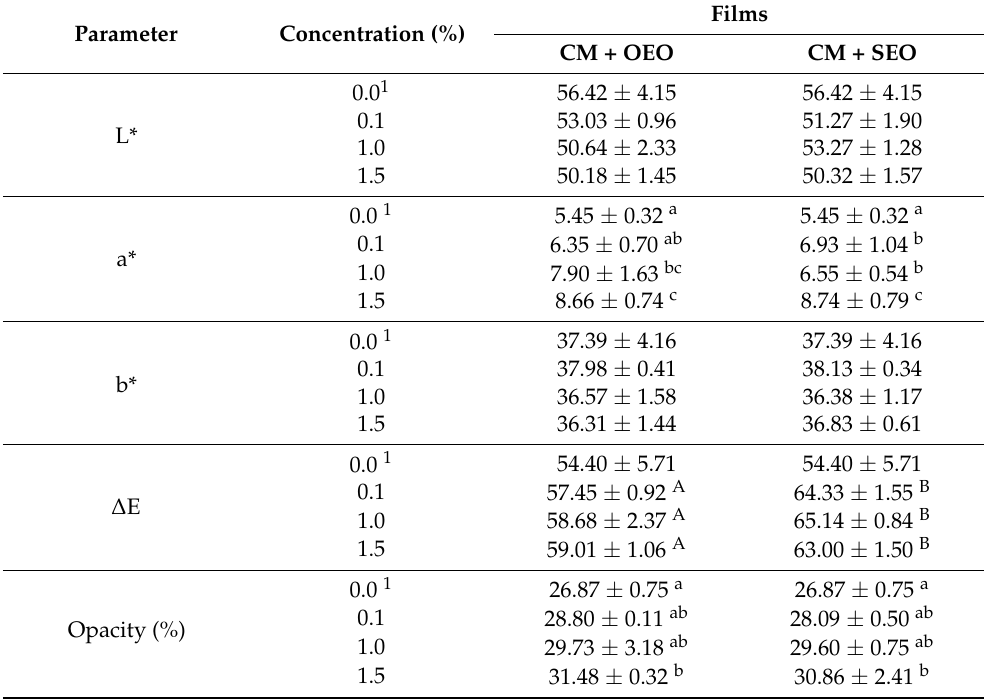
Table 2. Effect of oregano (OEO) or savory (SEO) essential oil addition in the optical properties of the chia mucilage films (CM) (mean ±